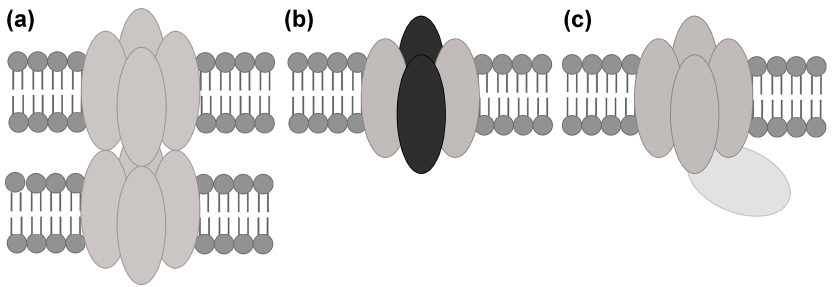
Figure 2. Types of AQP protein–protein interactions. AQP protein–protein interactions can typically be divided into: ( a ) interactions between AQP tetramers in supramolecular assemblies; ( b ) interactions between different AQP monomers (grey and black ovals) in hetero-tetramers and ( c ) transient interactions with regulatory proteins.